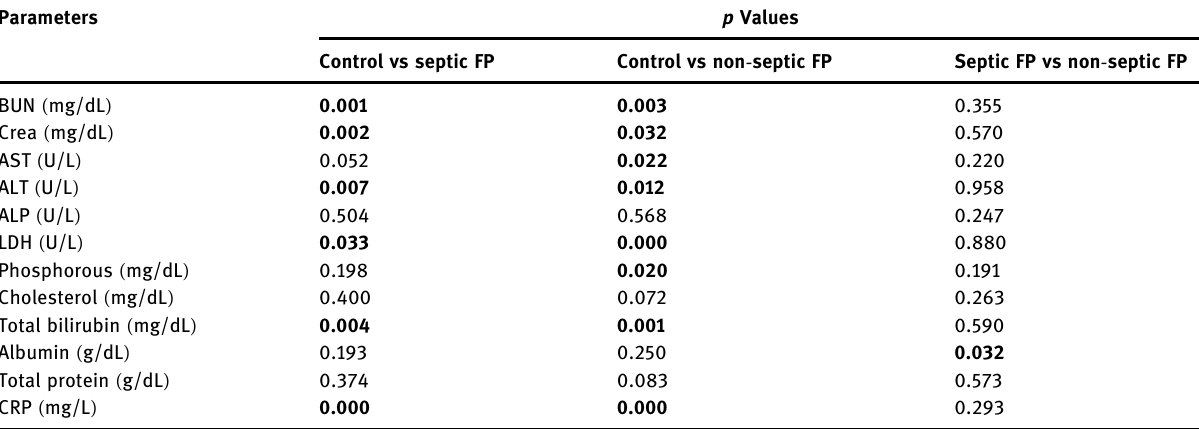
Table 7: p Values of intergroup comparison of serum biochemistry pro fi ling results ( p < 0.05: bold